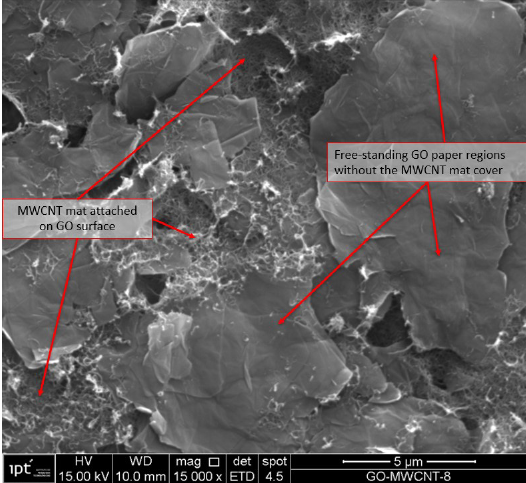
Figure 3. SEM image: the discontinuity of MWCNT mat at the GO paper surface at MWCNT_16%